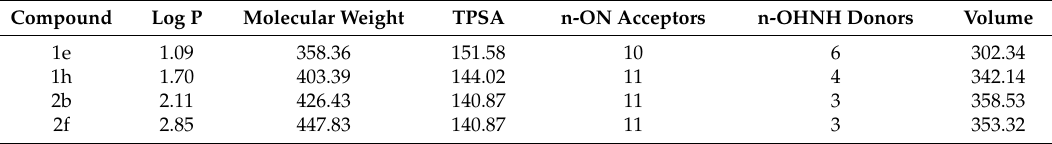
Table 2. Theoretical ADME properties of the most active adenosine